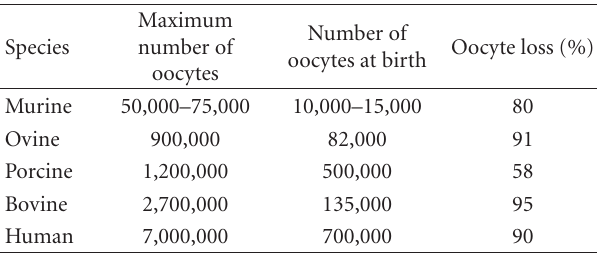
Table 1: Oocyte loss during meiosis